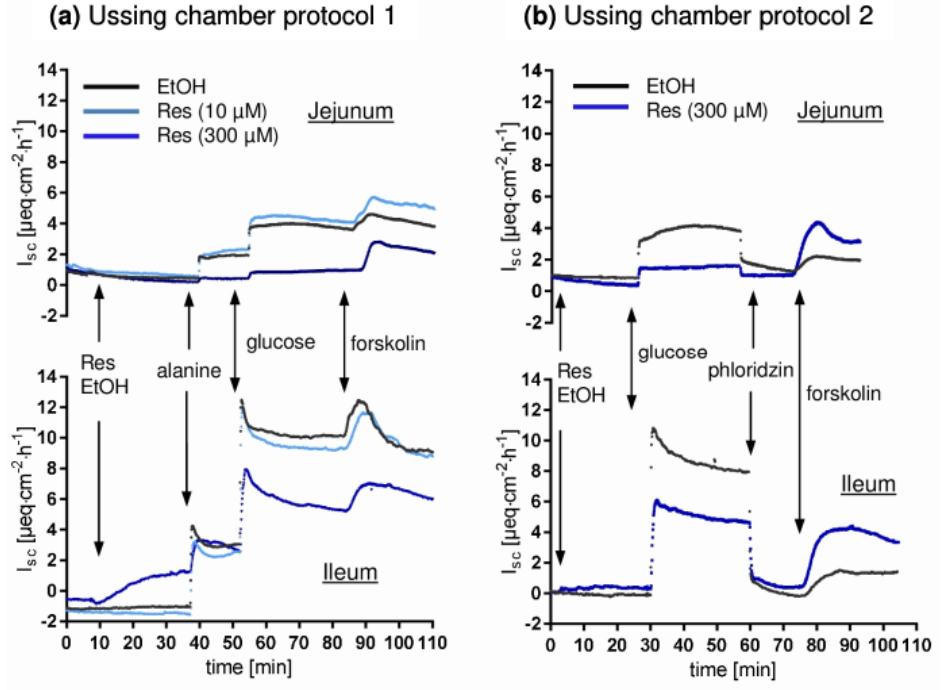
Figure 2. Representative time course of short circuit currents (I sc ) measured in Ussing chamber experiments. An increase in I sc represents either transepithelial cation absorption or anion secretion. ( a ) protocol 1 ( b ) protocol 2. The black line represents one solvent control chamber while light blue and dark blue represent the low (10 µ M) and high (300 µ M) concentrations of RSV. Glucose and alanine were added mucosal (10 mM), while mannitol was added to the serosal compartment for osmotic reasons. Phlorizin (mucosal) and forskolin (serosal) were used at a final concentration of 0.01 mM.